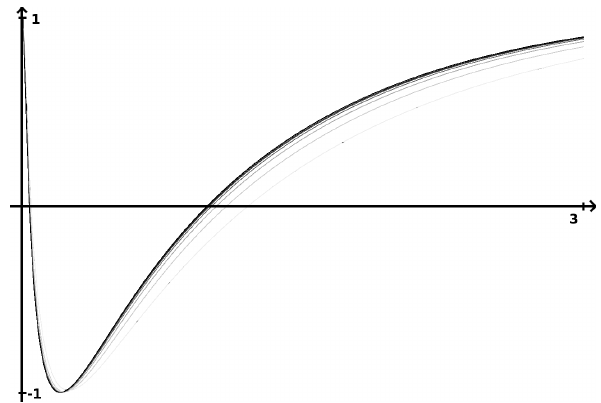
Figure 2. Uniform convergence of the modified generalized Hadamard integrals of order 2 of the function sin(log x ) on the interval ]0 , 3]. As the grey level becomes darker the value of the parameter w increases of a factor 2 starting from 10. Seven approximations are shown, therefore from w = 10 up to w = 640.